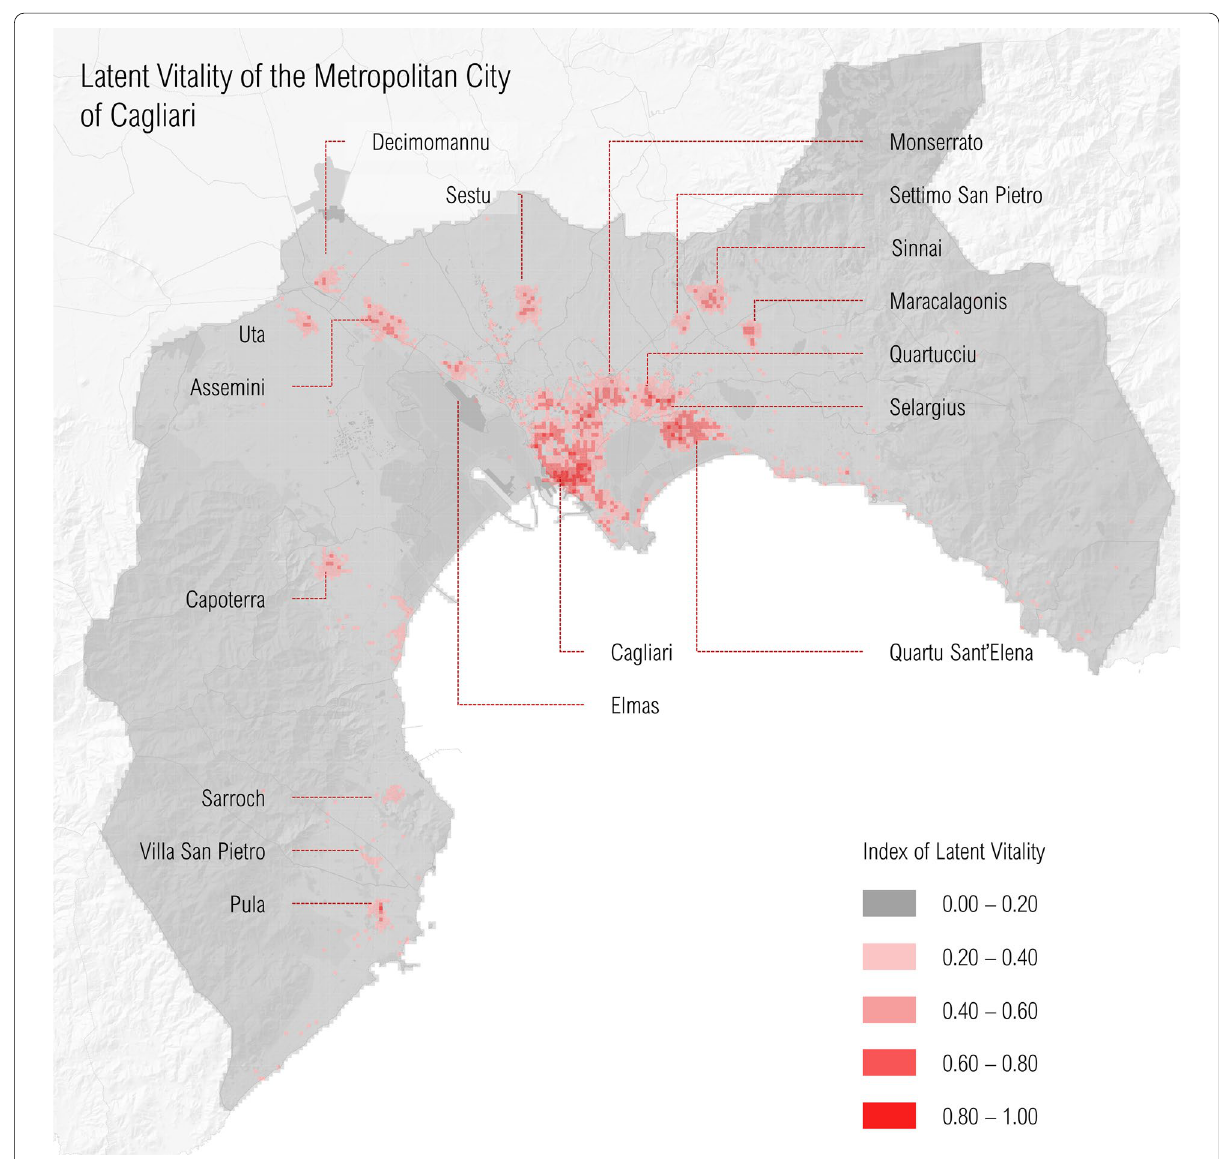
Fig. 4 Distribution of the values of the Synthetic Index of Latent Vitality (I_VIBE) in the Metropolitan City of